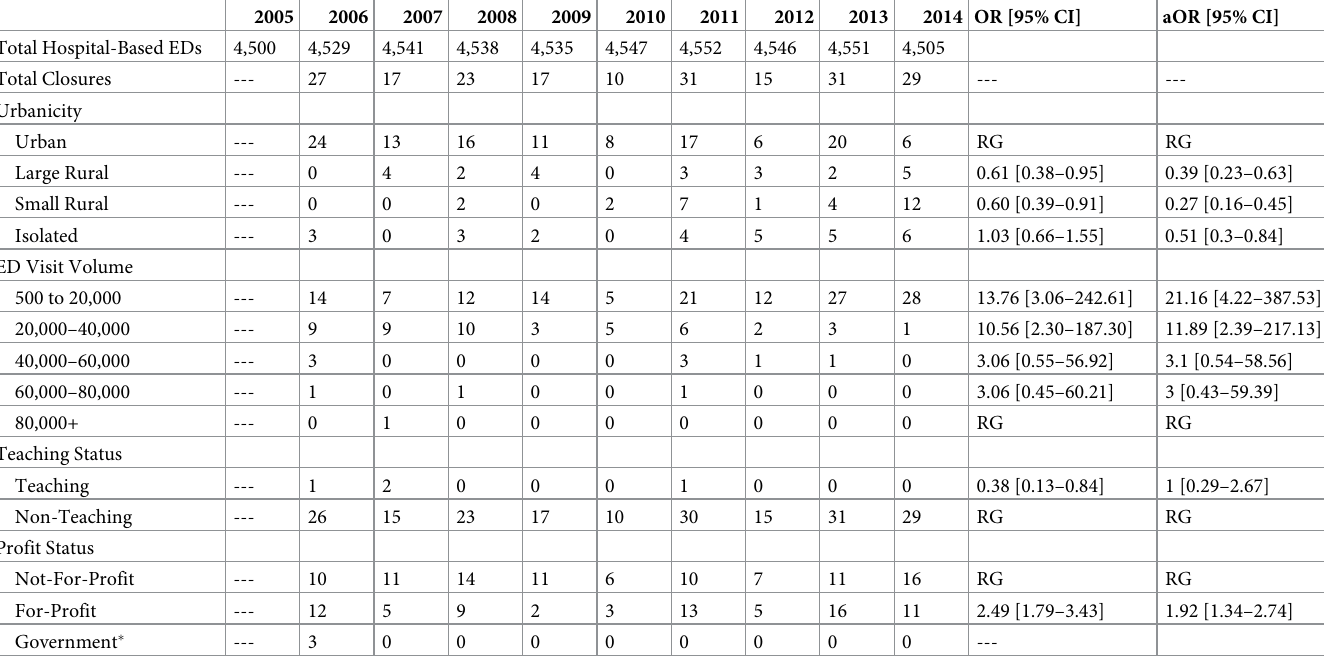
Table 1. Characteristics and risk factors for hospital-based ED closures,